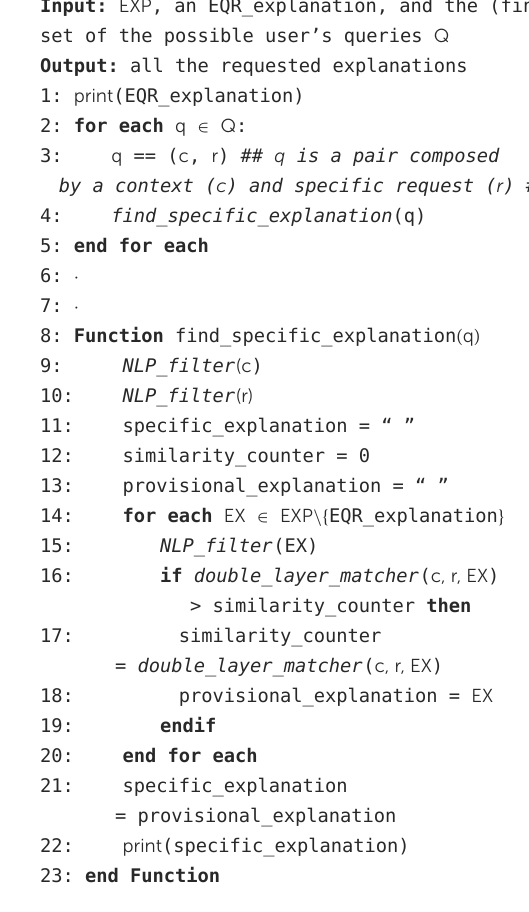
Algorithm 1. Matching